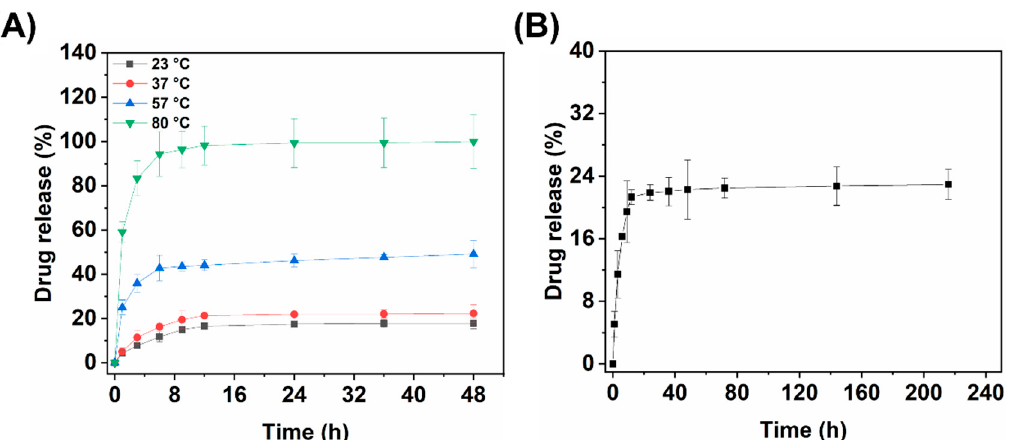
Figure 4. Release of Fe 3 O 4 @CS-ACVA-TB: ( A ) the release efficiency of TB from Fe 3 O 4 @CS nanoparticles in water bath at 23, 37, 57 and 80 °C. ( B ) the long-term release of TB at 37 °C. (n = 3).